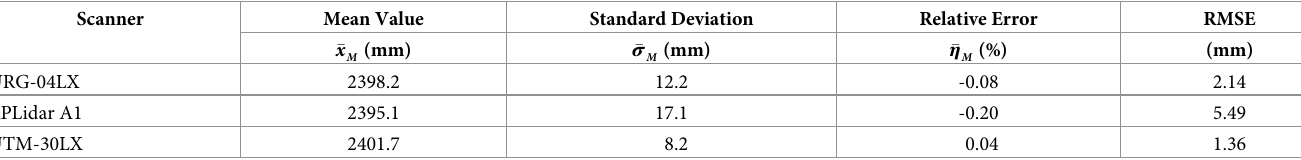
Table 4. Comparison of measuring stability of 2D laser scanners at 2.4 m